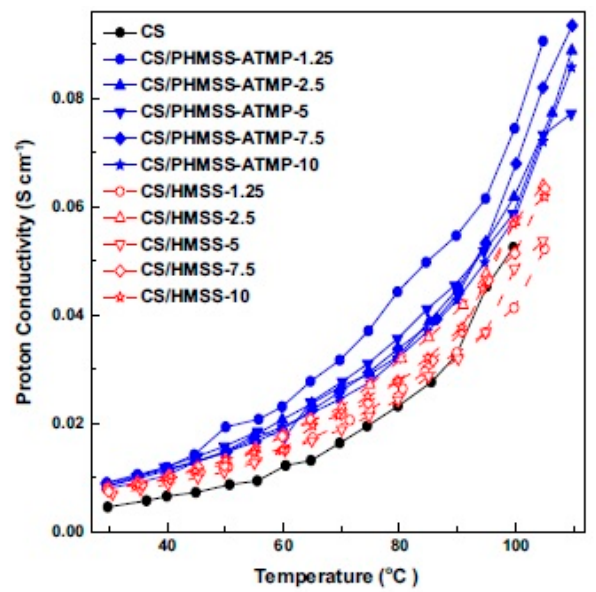
Figure 3. Proton conductivity of the pristine chitosan (CS), CS / HMSS, and CS / phosphorylated hollow mesoporous silica sub-microspheres (PHMSS)-ATMP hybrid membranes with increasing temperature at 100% relative humidity (RH) [28]. Copyright 2014, reproduced with permission from Elsevier